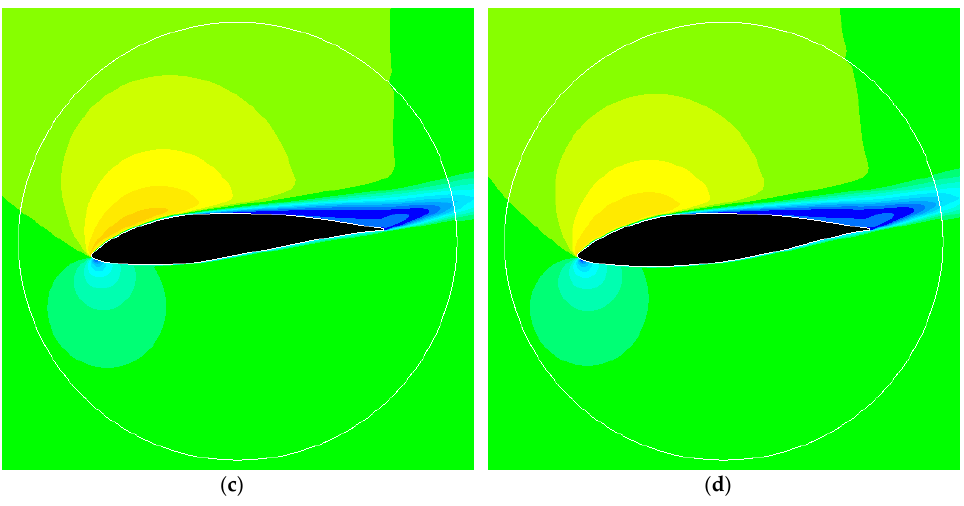
Figure 13. Predicted distribution of dimensionless velocity magnitude around the airfoil for Re = 100,000, BA = 5°, FA = 15° (AoA = 10°), for L/C = 6, ( a ) Original profile; ( b ) Point 1; ( c ) Point 2; ( d ) Point 3 (Figure 9).